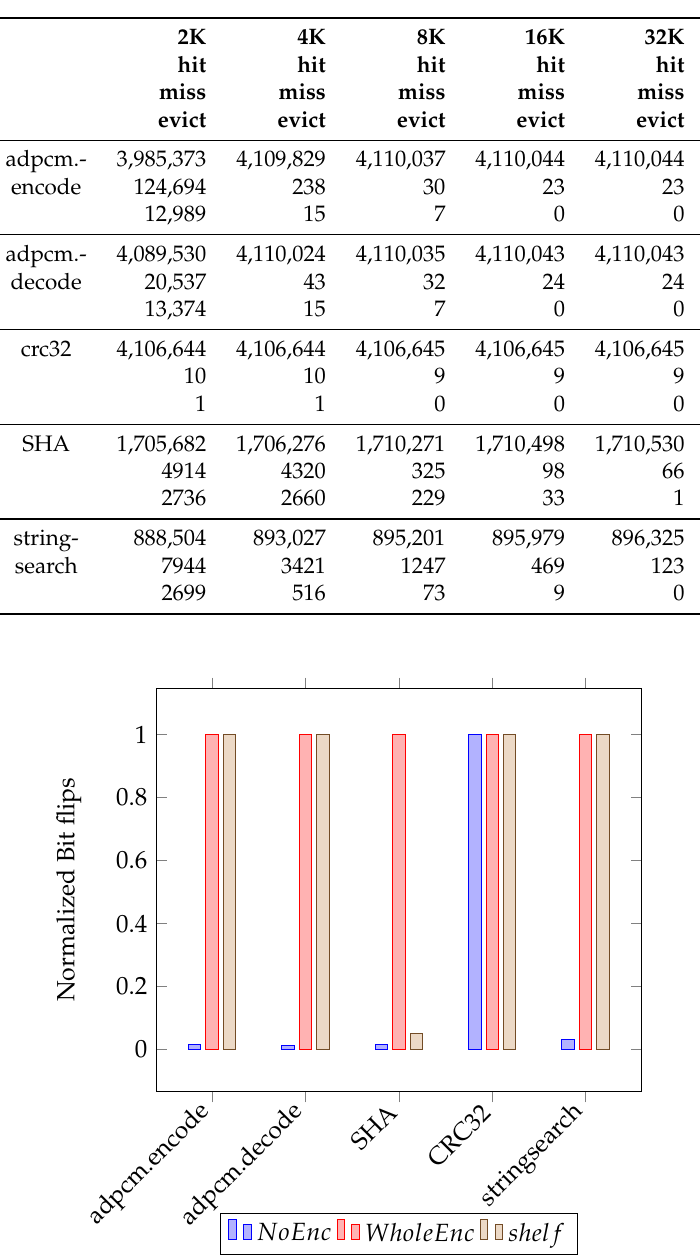
Table 2. SPM hits, misses and evictions.